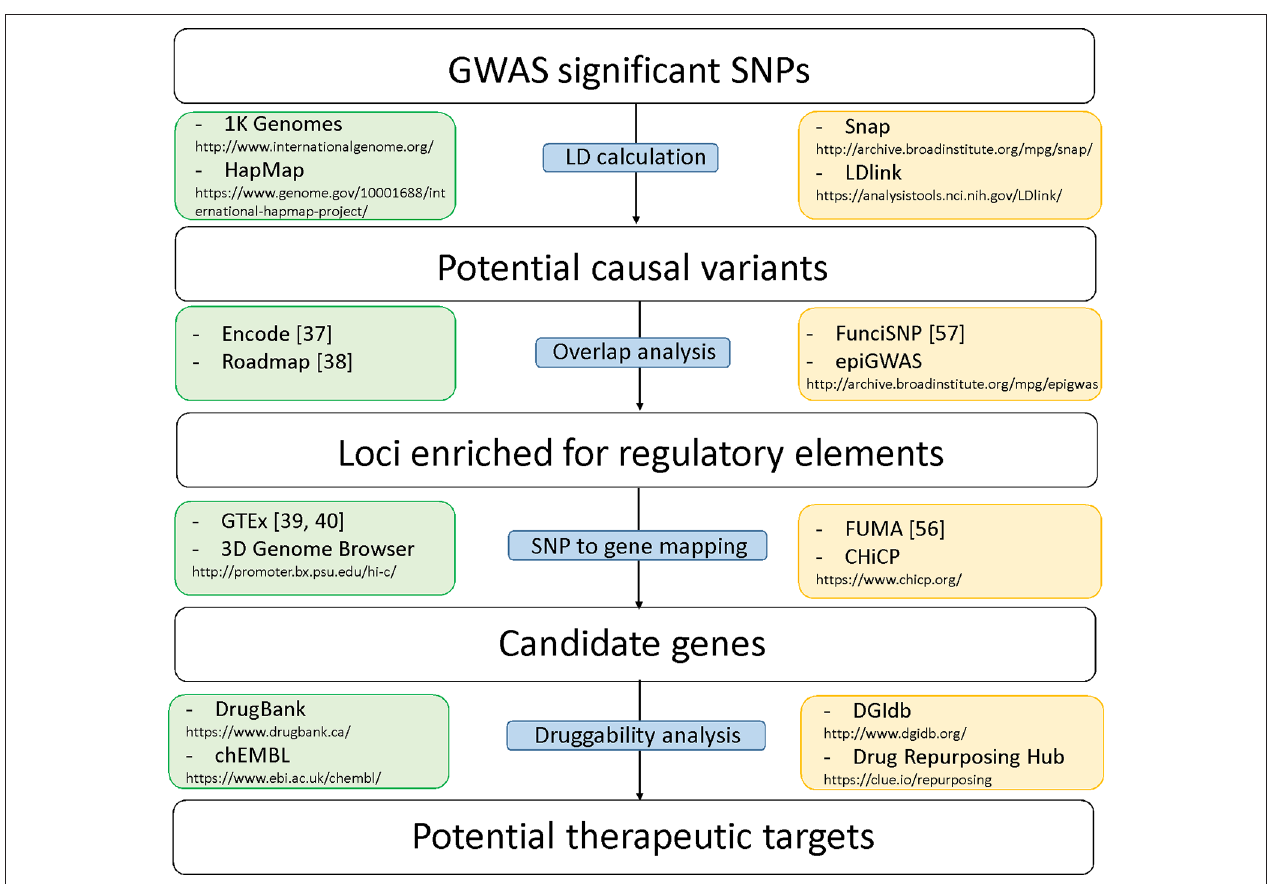
FiGuRe 2 | Diagram of analytical steps that can be followed for variant prioritization and translation of association to a potential drug target. Each step is accompanied by examples of publicly available data (green boxes on the left) and tools (yellow boxes on the right) that can be